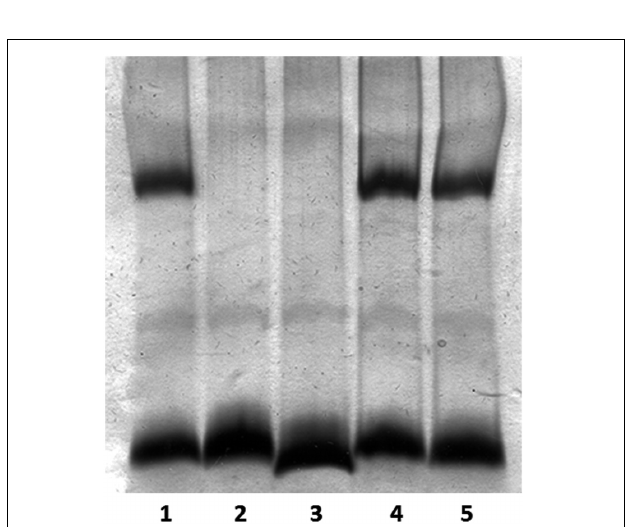
FIGURE 2 | Lipopolysaccharide (LPS) analyzed by SDS-Tricine gel and silver stained for A. hydrophila strains: AH-1 wild-type (lane 1), AH-1 (cid:49) rmlB mutant (lane 2), AH-1 (cid:49) wahD mutant (lane 3), AH-1 (cid:49) rmlB mutant complemented with pBAD-rmlB (lane 4), and AH-1 (cid:49) WahD mutant complemented with pBAD-wahA (lane 5).